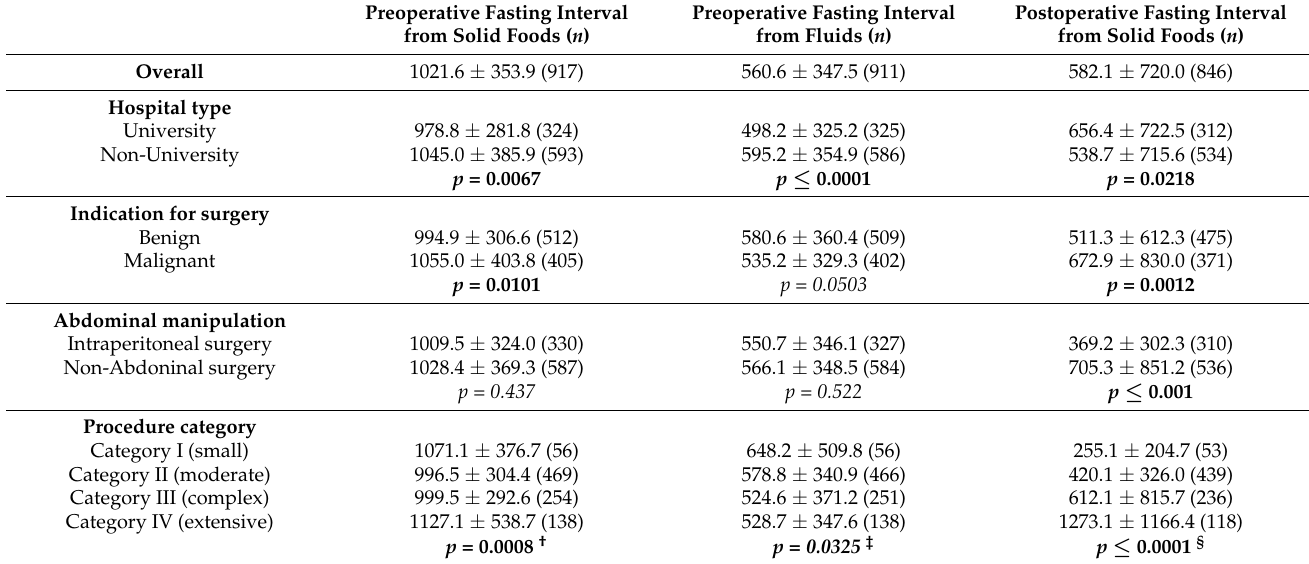
Table 2. Subgroup analysis for perioperative fasting intervals. From top to bottom are shown overall results and subgroup fasting intervals for hospital type, indication of surgery and procedure category. Data are presented as mean ± standard deviation in minutes. The number ( n ) of patients is displayed in parentheses behind the data. p -values of group comparisons are shown in italics: t -testing for hospital type and indication for surgery and ANOVA testing for procedure category. Details of multiple comparison testing of the procedure categories, p -values are indicated as follows: <0.05, ** < 0.01, *** < 0.001, **** < 0.0001. † II vs. IV ***, III vs. IV **; ‡ No significant results of multiple